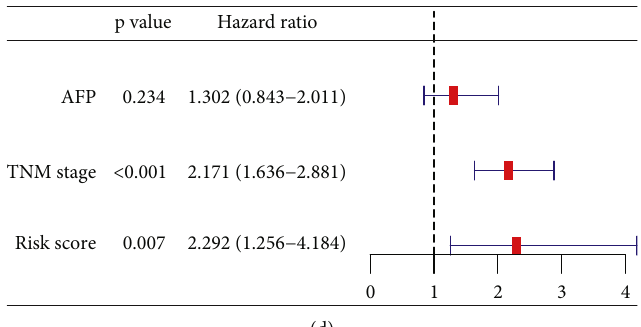
Figure 7: Independent prognostic value of the RS in HCC. (a – b) Univariate Cox analyses of RS and clinical characteristics in the TCGA cohort ( n = 339 ) (a) and GSE14520 ( n = 220 ), (b). (c) Multivariate Cox analyses of RS and TNM stage in the TCGA cohort. (d) Multivariate Cox analyses of RS, AFP, and TNM stage in